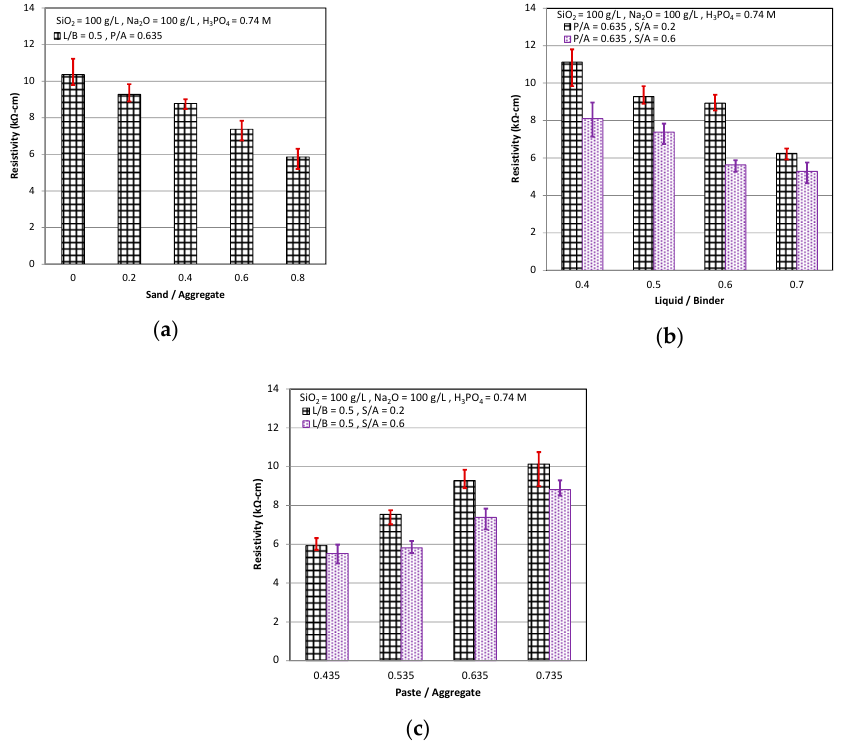
Figure 5. Resistivity: ( a ) P/A = 0.635, L/B = 0.5; ( b ) P/A = 0.635, S/A = 0.2 & 0.6; and ( c ) L/B = 0.5, S/A = 0.2 &